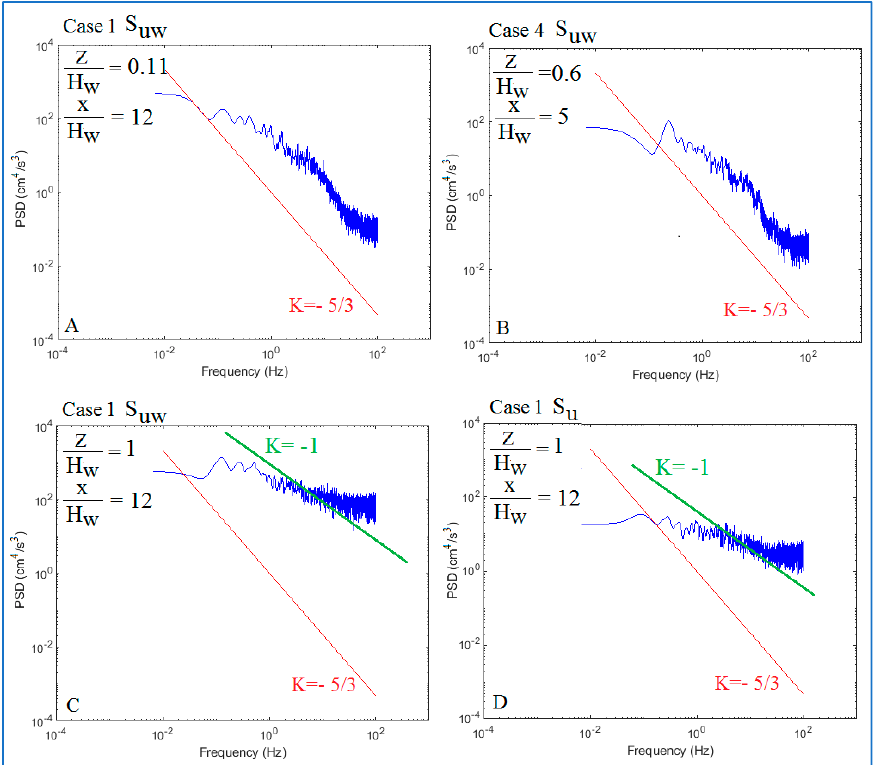
Figure 4. Samples of the power spectra behind the patch showing different classes of turbulence: (A) isotropic–homogenious turbulent flow without dominant frequency on S uw , ( B ) isotropic– homogenious turbulent flow with dominant frequency on S uw, observed below the height of the patch, ( C ) anisotropic turbulent flow with dominant frequency on S uw , observed alongside the height of patch, ( D ) S uw of the same anisotropic sample.